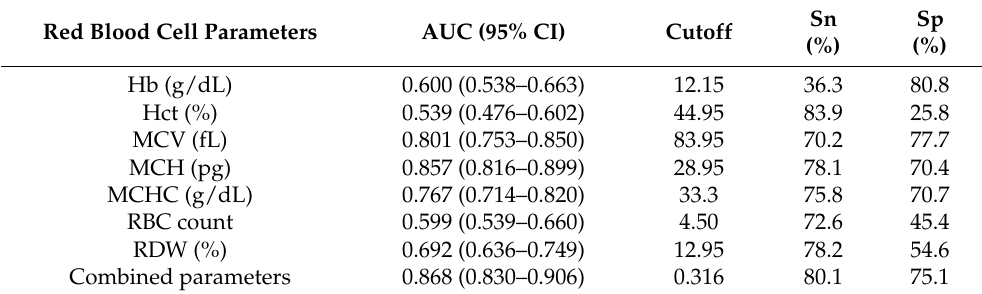
AUC, area under the curve; CI, confidence interval; Hb, hemoglobin; Hct, hematocrit; MCH, mean corpuscular hemoglobin; MCHC, mean corpuscular hemoglobin concentration; MCV, mean corpuscular volume; RBC, red blood cell; RDW, red blood cell distribution width; Sn, sensitivity; Sp,